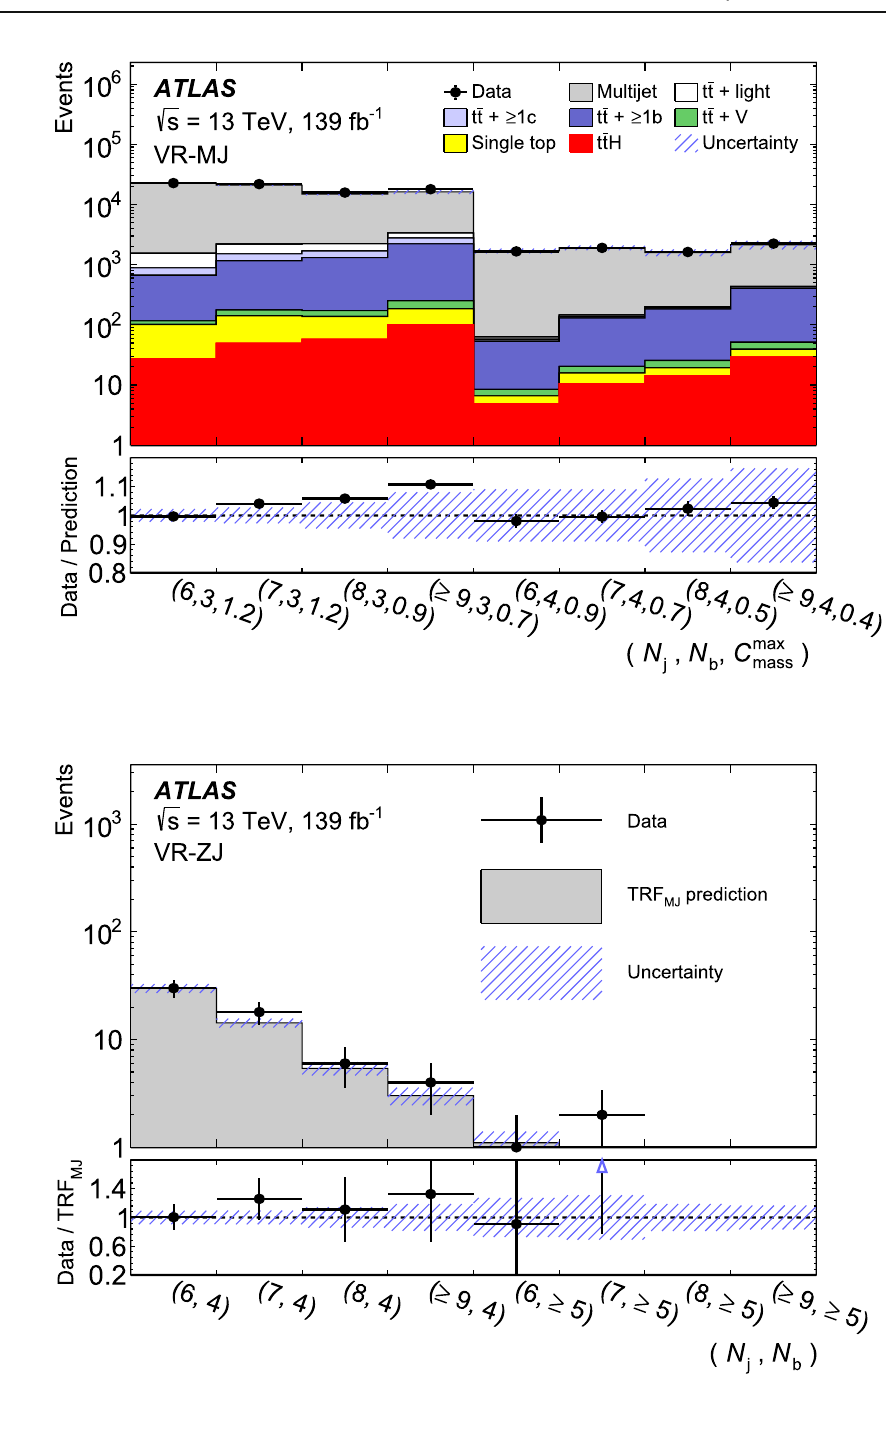
Fig. 4 Comparison between data and the predicted number of events with N j = 6, 7, 8 and ≥ 9 and N = 3 and 4 in the b VR-MJ validation regions, which are based on a maximum value of the centrality mass, C max mass . The bottom panel displays the ratios of data to the total prediction, uncertainty bars are statistical only. The systematic uncertainties listed in Sect. 7 are represented by the blue hatched area